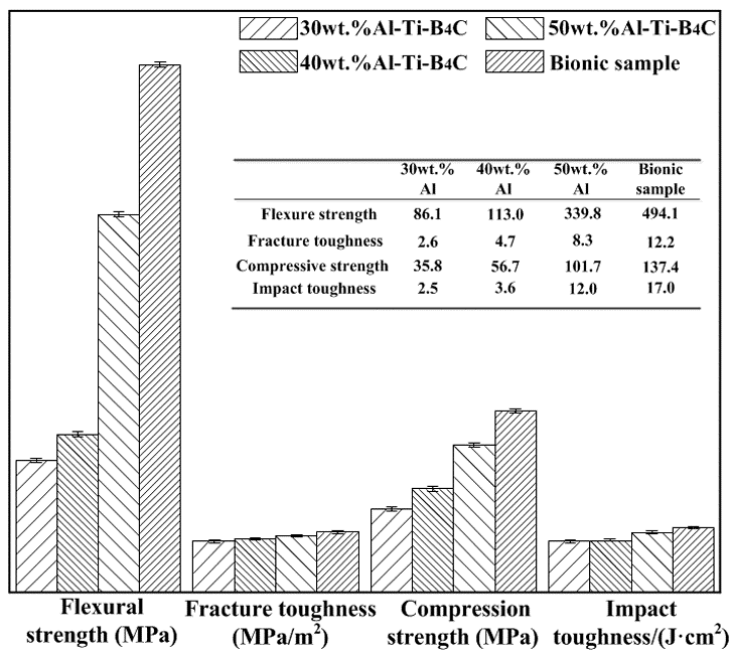
Figure 6. Flexural strength, fracture toughness, compression strength and impact toughness values of 30 wt. %–50 wt. % Al-Ti-B 4 C composite and bionic layered composite. 30 wt. %–50 wt. % Al-Ti-B 4 C composite and bionic layered